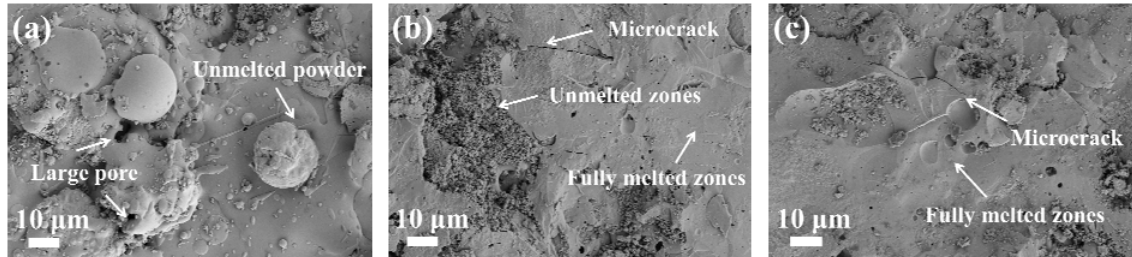
Fig. 6 SEM images of the plasma-sprayed HE-RE 3 Al 5 O 12 coating surfaces: (a) HE-RE 3 Al 5 O 12 -1; (b) HE-RE 3 Al 5 O 12 -2; and (c) HE-RE